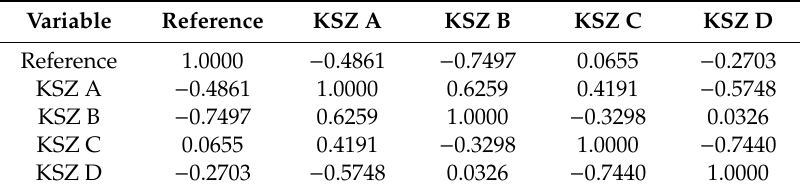
Table 11. The correlation coe ffi cient of tensile strength obtained in various ageing variants under thermal shock conditions and in the reference condition (for significance coe ffi cient p <